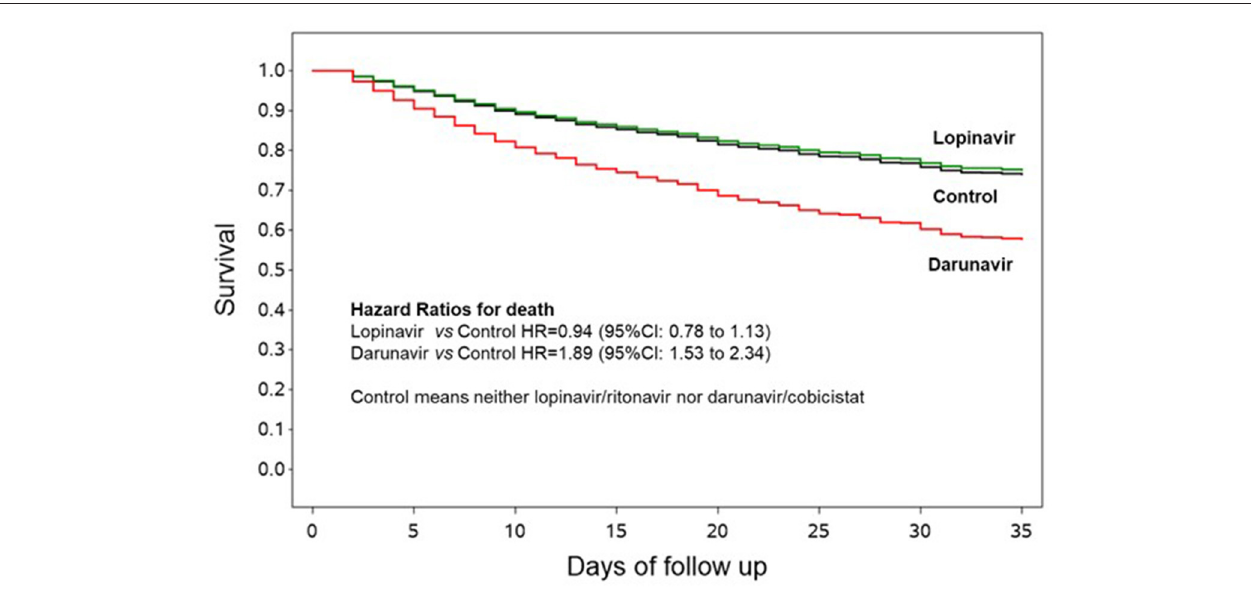
FIGURE 1 | Survival curves according to lopinavir/ritonavir or darunavir/cobicistat use. The curves are adjusted by propensity score analysis (inverse probability by treatment weighting) and hospitals clustering as random effect, and are generated using the first imputed dataset. The other imputed datasets are similar and thus